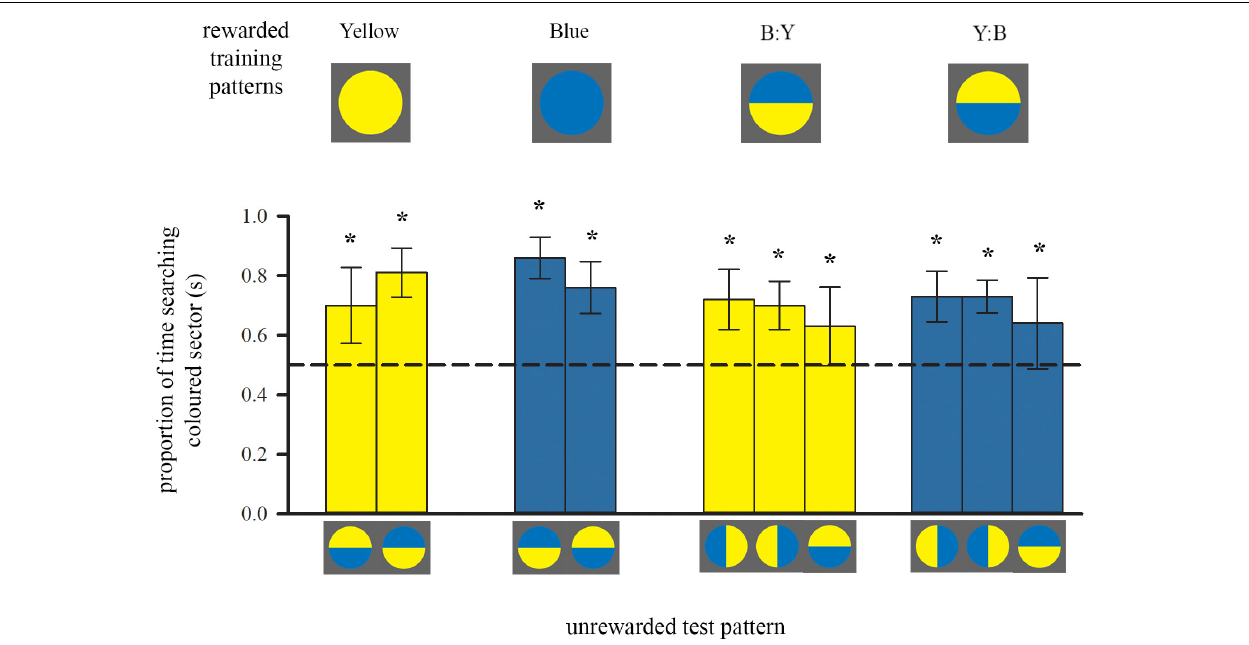
FIGURE 2 | Colour preferences of trained bees in each of either two or three unrewarded tests after training to single-colour discs or bicolour patterns, respectively. Bees inspected the unrewarding test pattern whilst flying in front of it, within a distance of 5 cm. Bars represent the mean proportion of time spent flying in front of the test pattern segment that was of either the colour of the trained single-coloured disc or the colour of the lower half of the bicolour training pattern (also depicted by bar colour), relative to the search on the other segment of the test pattern. For sample sizes see Figure 1 . During each test only one of the test patterns was presented. Error bars represent ± 1 standard deviation. Asterisks * above bars denote a significant deviation from equal choice at α = 0.05 (Paired t -tests; see also Supplementary Table 1